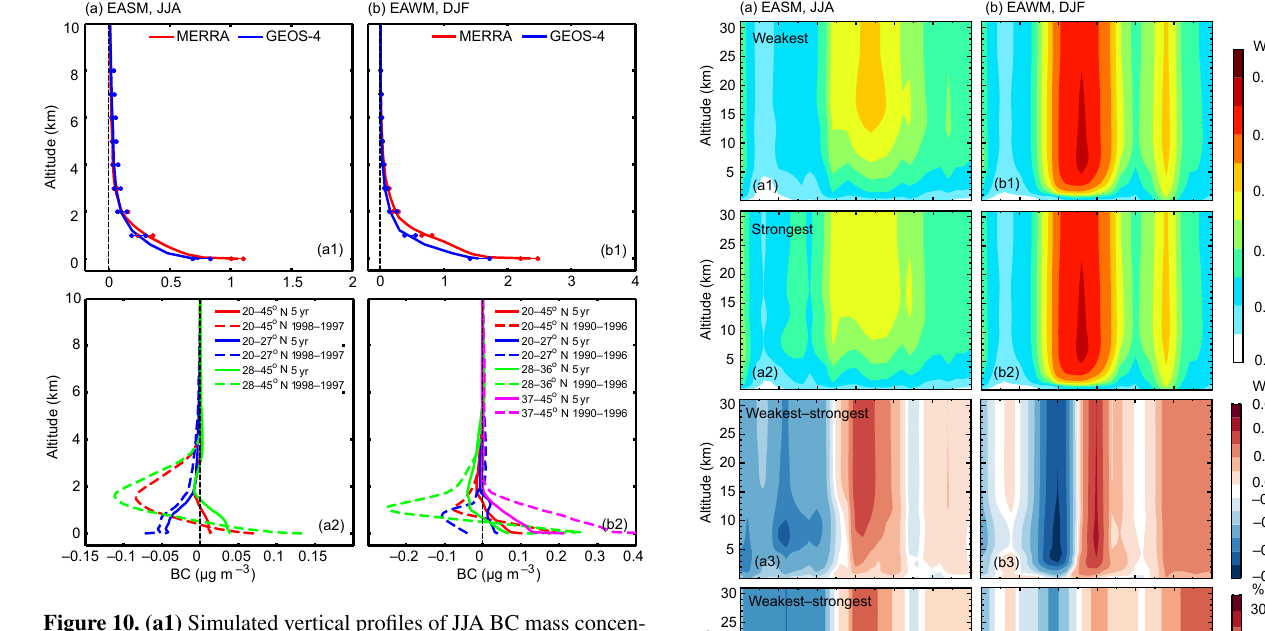
Figure 10. (a1) Simulated vertical profiles of JJA BC mass concen- trations (µgm − 3 ) averaged over 1986–2006. The error bars repre- sent the minimum and maximum values of BC. Results are aver- ages over eastern China from model simulations VMETG4 (blue) and VMET (red). (a2) Differences in simulated vertical profiles of JJA BC mass concentrations (µg m − 3 ) between the 5 weakest and 5 strongest EAM years (solid lines) during 1986–2006, and between the weakest and strongest EASM years (1998–1997, dot- ted lines). Results are averages over eastern China, northern China, and southern China from model simulation VMET. (b1) Same as panel (a1) , but for simulated DJF BC mass concentrations. (b2) Same as panel (a2) , but for differences in DJF between the 5 weakest and 5 strongest EAWM years and between the weakest and strongest EAWM years (1990–1996). Results are averages over eastern China, the North China Plain, the Central China Plain, and southern China.